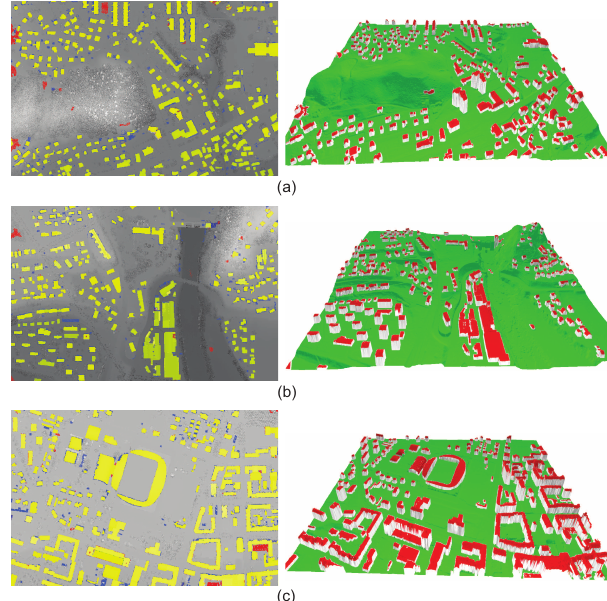
Figure 3: The results obtained by the proposed method on test- sets (a) DS1, (b) DS2, and (c) DS3, where (left) the heightmaps are coloured according to the ground-truth data. The yellow colour represents true-positives, the red colour false-positives, and the blue colour is used to show false-negatives. The extracted building points are (right) triangulated and visualised together with the generated DTM, based on Mongus and ˇZalik